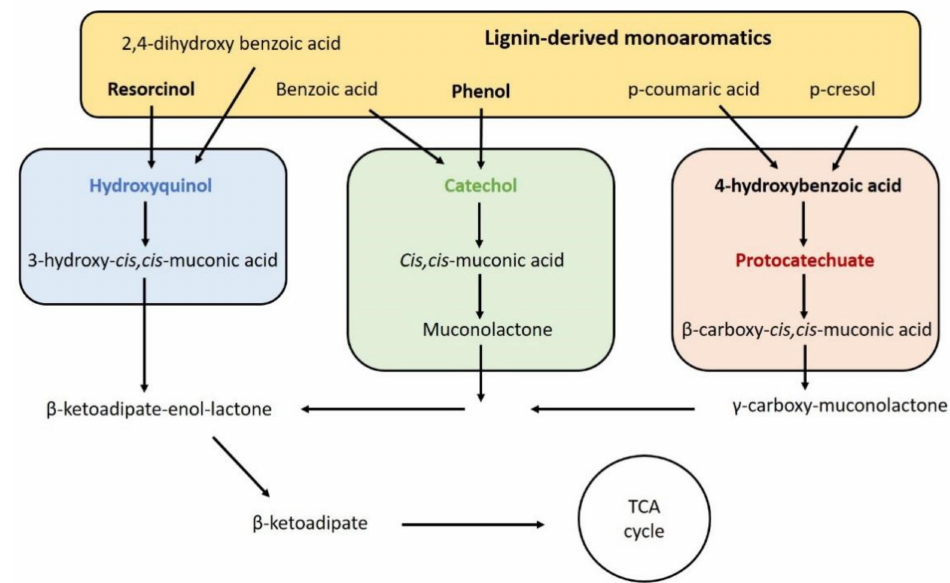
Figure 2. Schematic depiction of the three main funneling pathways for aromatic metabolism: hydroxyquinol (blue), catechol (green), and protocatechuate (red). Trichosporon oleaginosus is able